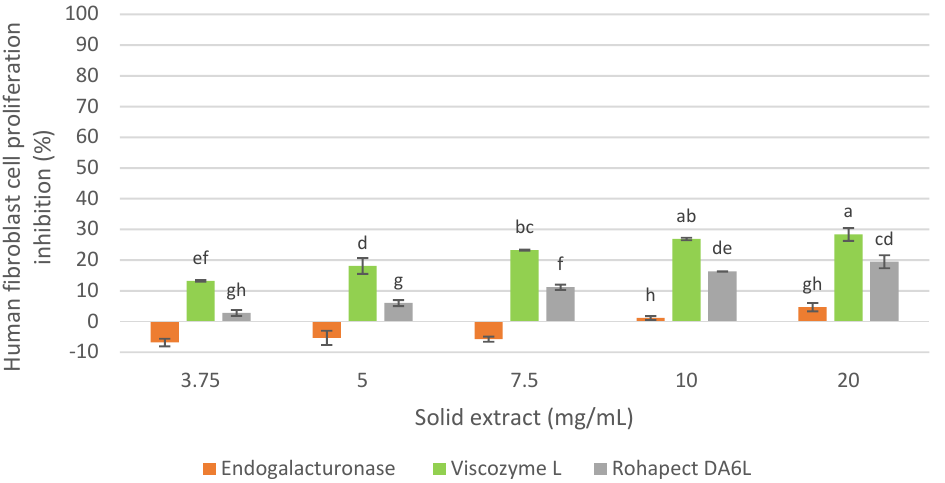
Figure 3. Human fibroblast cell proliferation inhibition of oligosaccharide extract obtained with commercial enzyme preparations from RM. Percentages of inhibition are calculated in reference to the signal of cells grown of extract-free cell culture media. Mean ± SD ( n = 3). The median that does not share a letter are significantly different ( p > 0.05), comparing all values together with ANOVA and Tukey’s test.